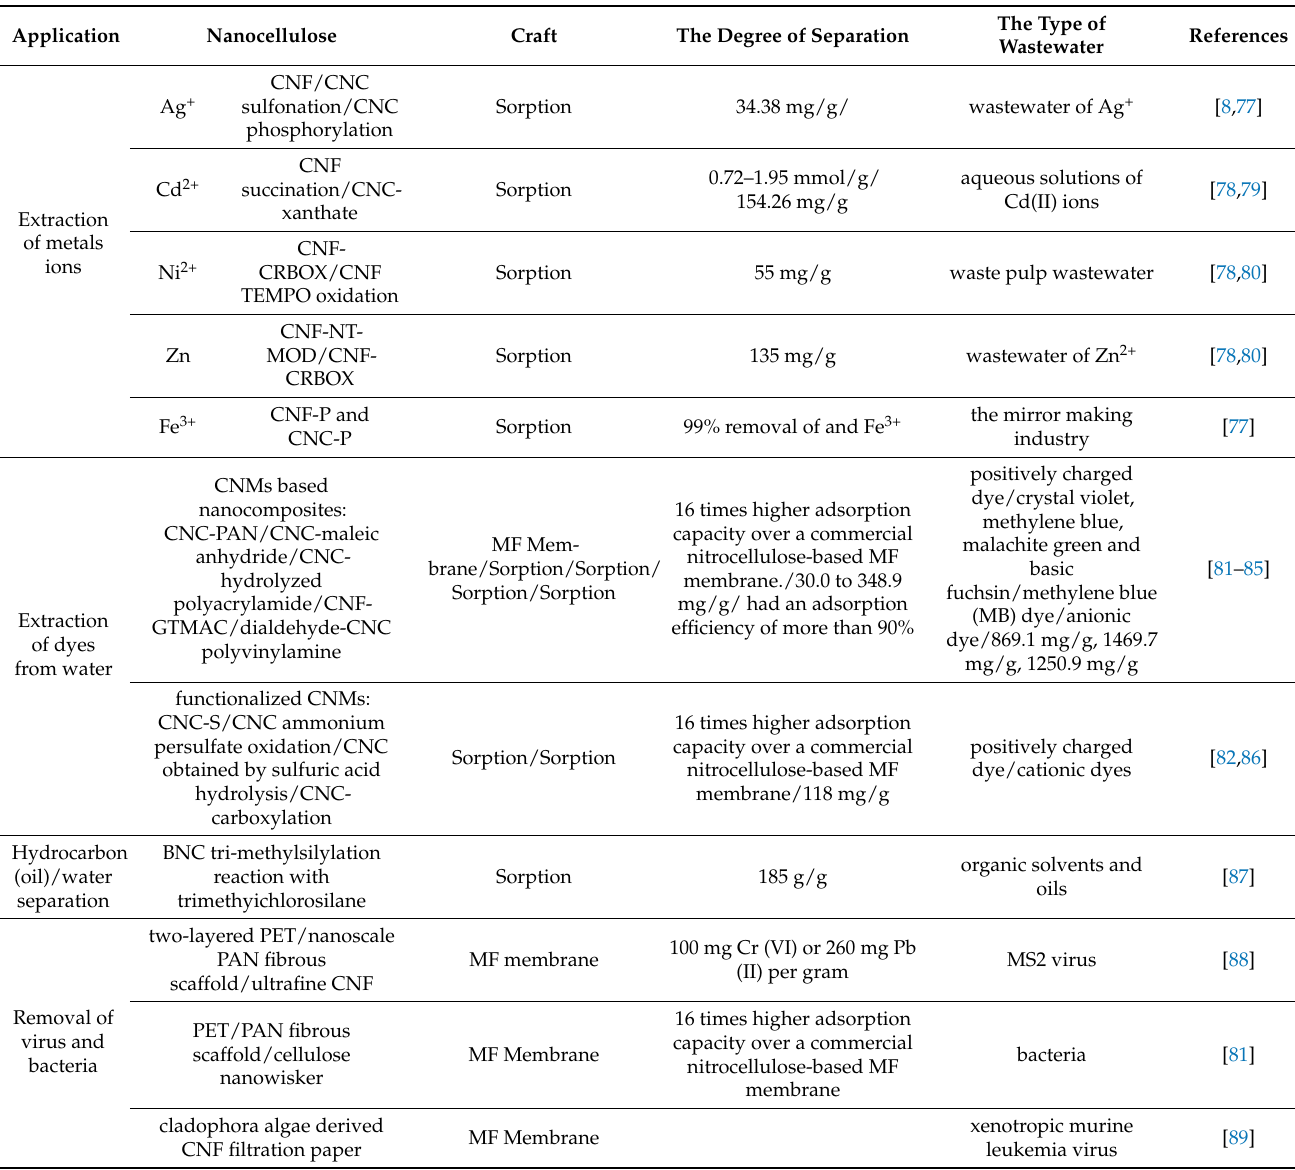
Table 2. Application of nanocellulose and its derivatives in wastewater